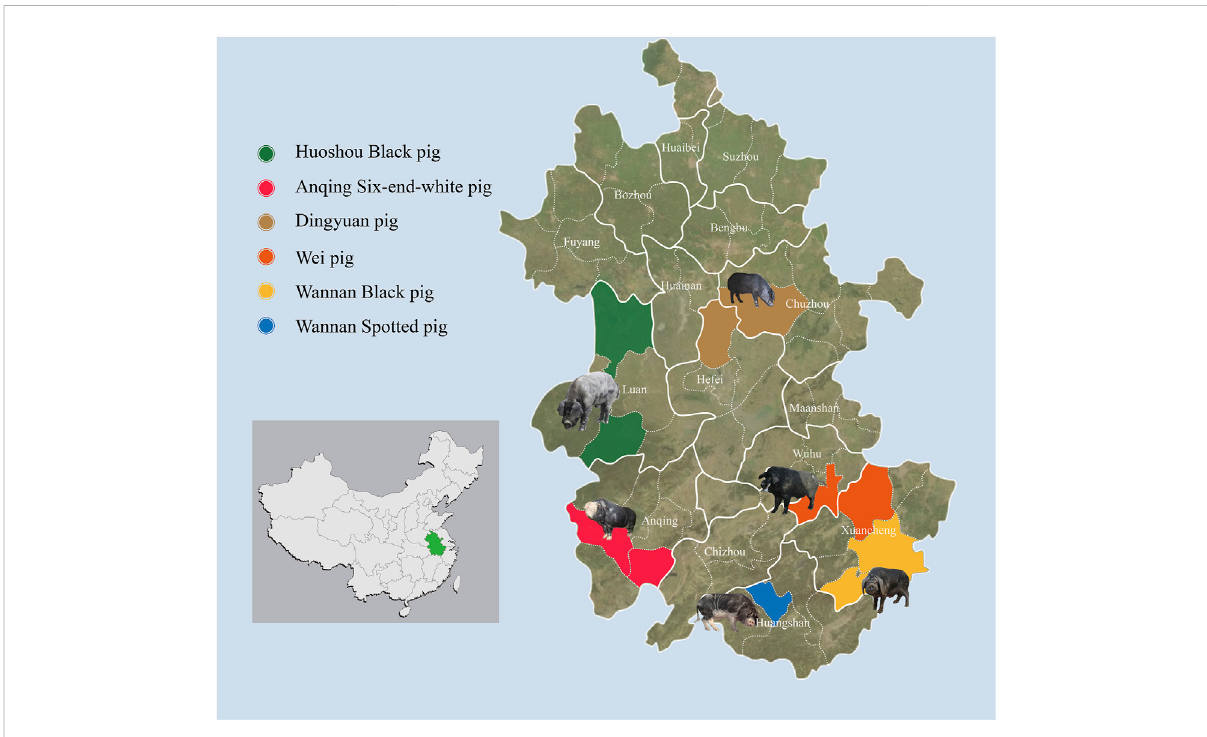
FIGURE 1 Geographic distribution and appearances of typical pigs. 150 Anhui indigenous pigs representing six populations were